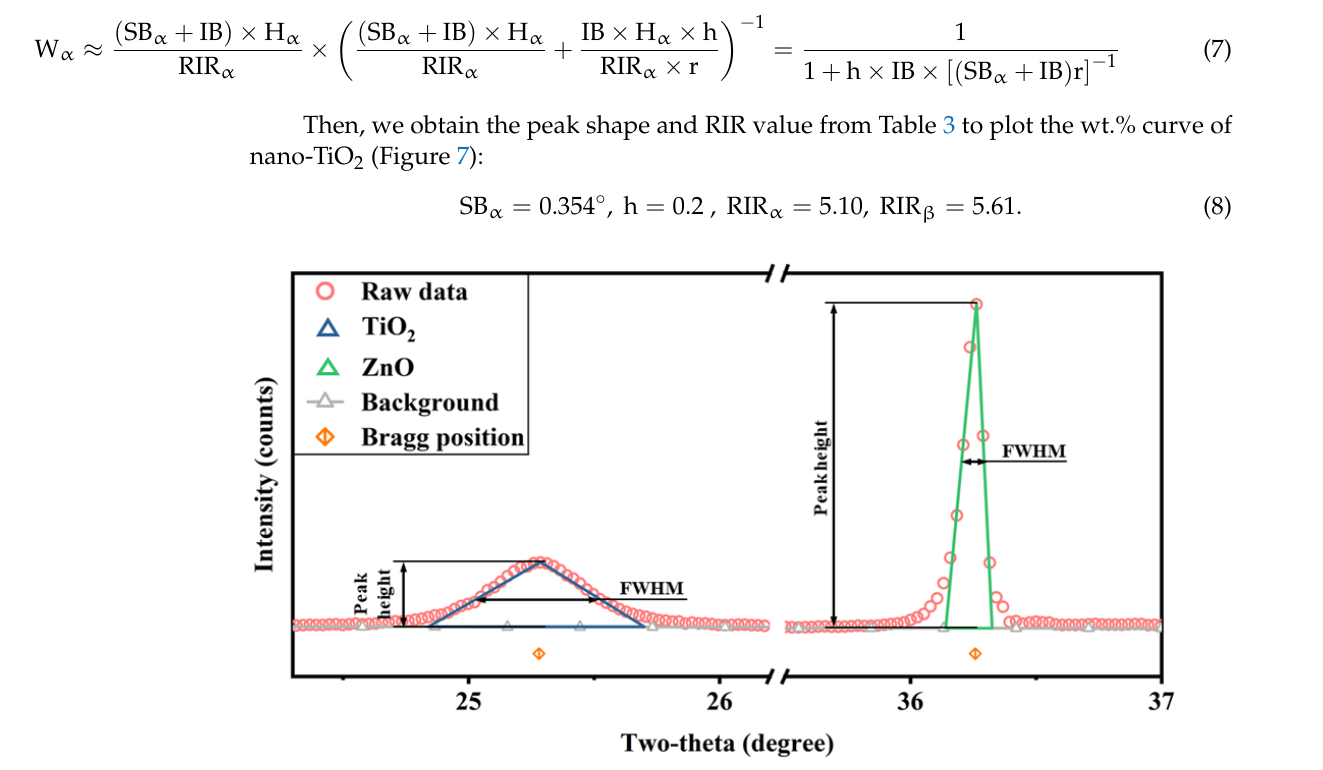
Figure 6. Approximate model of diffraction peak, in which the integral area is approximately FWHM multiplied by the peak height.